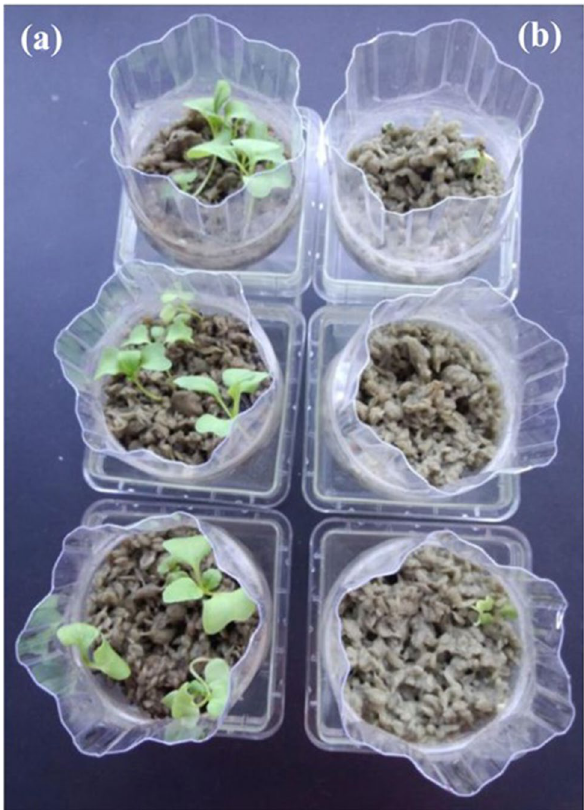
Figure 6. Plant growth on the inoculated carrier and the uninoculated materials. Komatsuna seeds were sown in ( a ) the inoculated carrier that had acquired the ability to degrade organic substances into inorganic nutrients or ( b ) uninoculated rockwool, and then grown at 25 °C. The photo shows plants at 11 days after